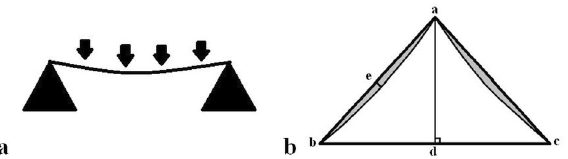
Figure 1. Free wall deflection as a simply supported beam. ( a ) A line drawing showing that a simply supported beam will deflect when under an equally distributed force depending on the size of the force, the beam length, thickness and stiffness. ( b ) A line drawing of an idealized sagittal sinus. Point “a” is at the falx vertex and both “b” and “c” are the bony attachments. If the attachments are fixed in position is can be shown that the two free walls a-b and a-c would be deflected inwards by the transmural pressure similar to the simply supported beam. The difference in the area between the triangle subtended by the vertices and the actual area (shown in grey) is related to the deflection distance at “e” by the length a-b using Eq. (4). The perpendicular height is the line a–d.